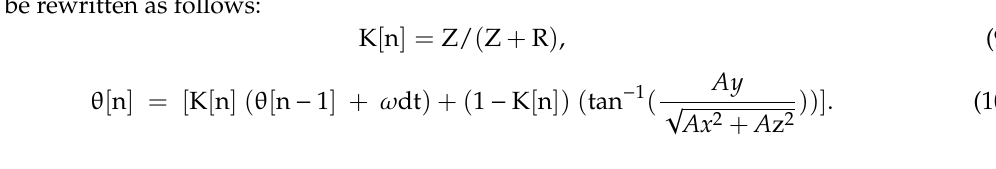
Figure 8. C onventional complementary filter.